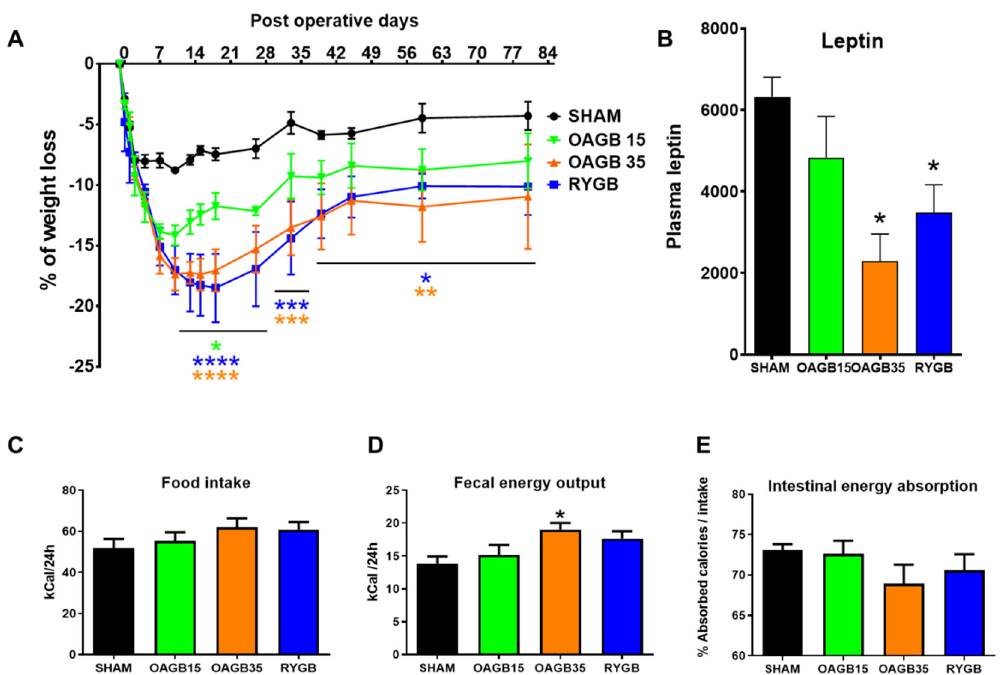
Figure 1. Shortening the BPL of OAGB affects body weight, but not food intake and absorption. ( A ) Weight loss and regain according to surgical procedure during 24 post-operative weeks expressed as % of initial weight. * p < 0.05; ** p < 0.01, *** p < 0.001, **** p < 0.0001 for OAGB-15 (green) OAGB-35 (orange) or RYGB (blue) vs. Sham (black) animals by Dunnett’s multiple comparison tests after 2-way RM ANOVA. ( B ) Plasma leptin levels in fasted animals 75 days post-operation. * p < 0.05 versus Sham animals by Dunn’s multiple comparison tests after Kruskal–Wallis Test. ( C – E ) Daily food intake ( C ), fecal energy outputs ( D ) and calculated intestinal energy absorption ( E ) during the 6th post-operative week. * p < 0.05 for OAGB-35 vs. Sham, no statistical difference was observed after Kruskal–Wallis Test. Data are expressed as means ± SEM, SHAM n = 6, RYGB n = 6, OAGB15 n = 5, OAGB35 n =